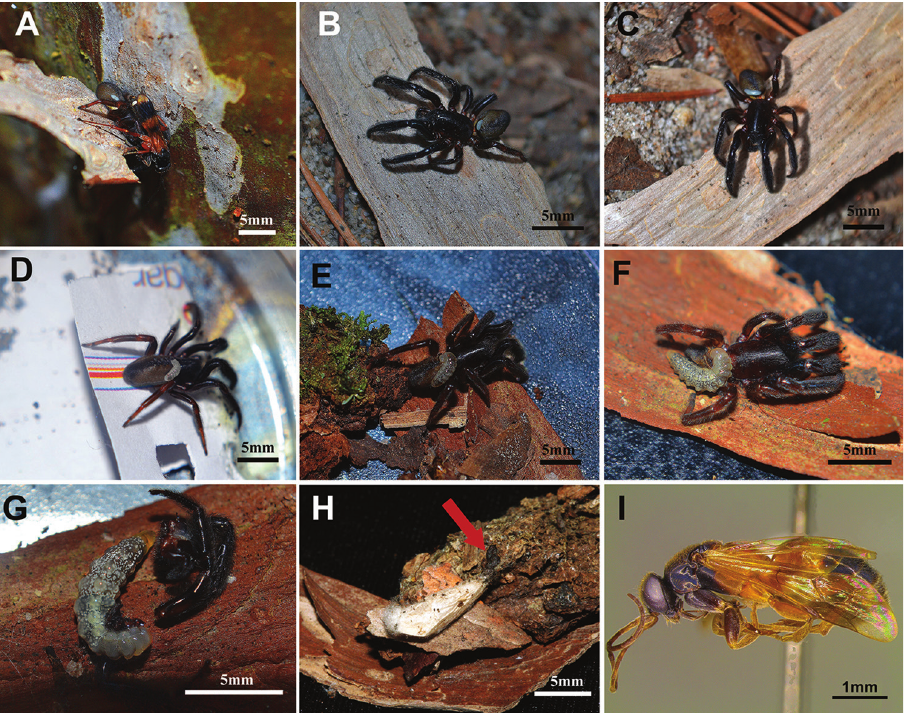
Figure 1. Adult female of Ariadna mollis (Segestriidae) parasitized by Epipompilus excelsus (Pompilidae). A) Wasp on the back of the spider (the arrow indicates the position of the egg in the abdomen). B) A. mollis moving slowly minutes after being paralyzed. C) Larval I instar of the wasp adhered to the abdomen of the spider. D) Larval II instar. E) Larval III instar. F) Larval IV instar feeding from the abdomen of the spider. G) Larva eating the remains of the legs and abdomen of the spider. H) The cocoon containing the meconium (red arrow). I) Adult female of E. excelsus